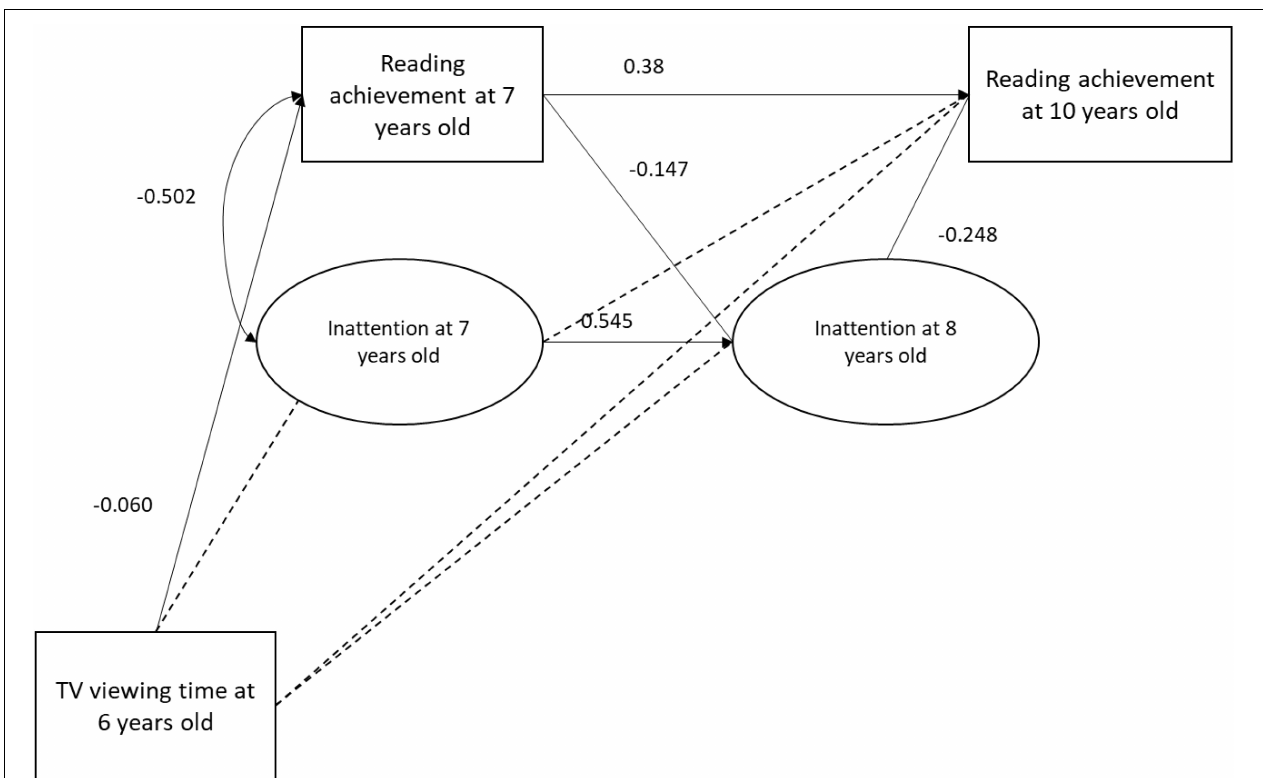
FIGURE 4 | Inattention mediation model. Dotted line indicates a p -value above 5%.